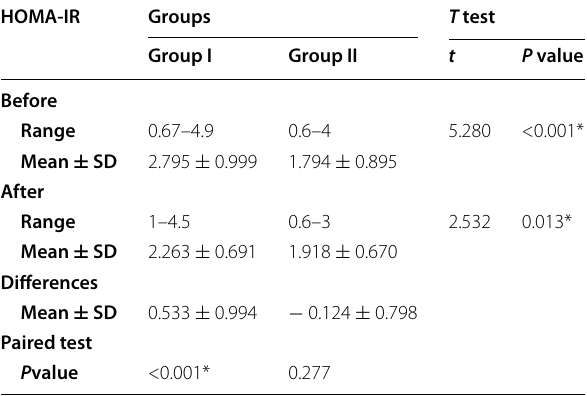
t Student’s t test, p p value for comparing between the two groups